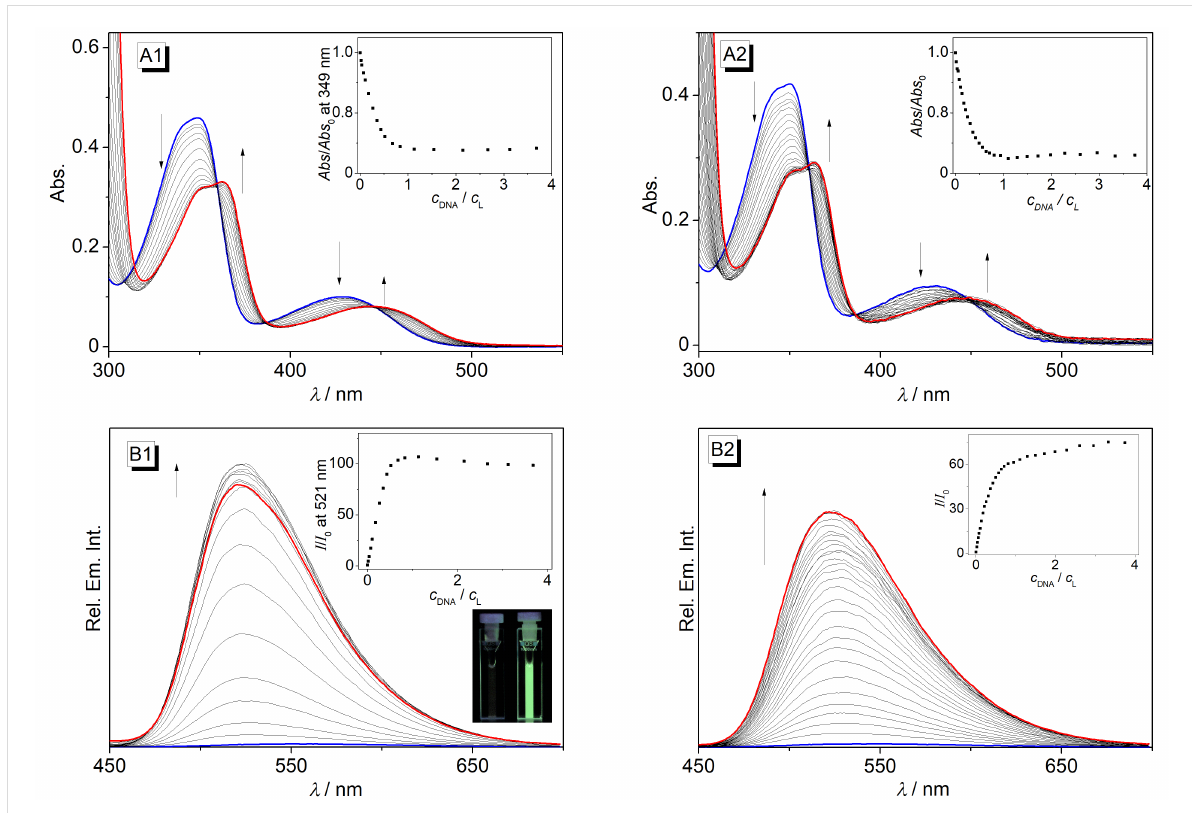
Figure 1: Representative spectrophotometric (A) and spectrofluorimetric (B) titration of compound 4c with 22AG (1) and a2 (2) ( c 3c = 20 μ M; c DNA = 200 μ M) in K + -phosphate buffer (pH 7.0) with 10% v/v DMSO). The arrows indicate the development of the absorption or emission bands with increasing DNA concentration. Insets: Plots of Abs. / Abs. 0 and I / I 0 , respectively, versus c DNA / c 3c . Inset B1: Picture of the emission color and intensity of compound 4c in the absence (left) and the presence (right) of 22AG .